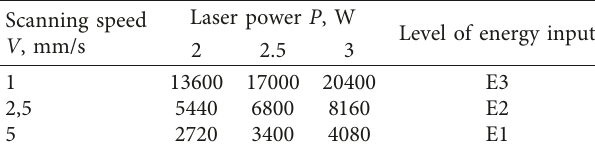
Table 3: Calculated energy density (J/cm 2